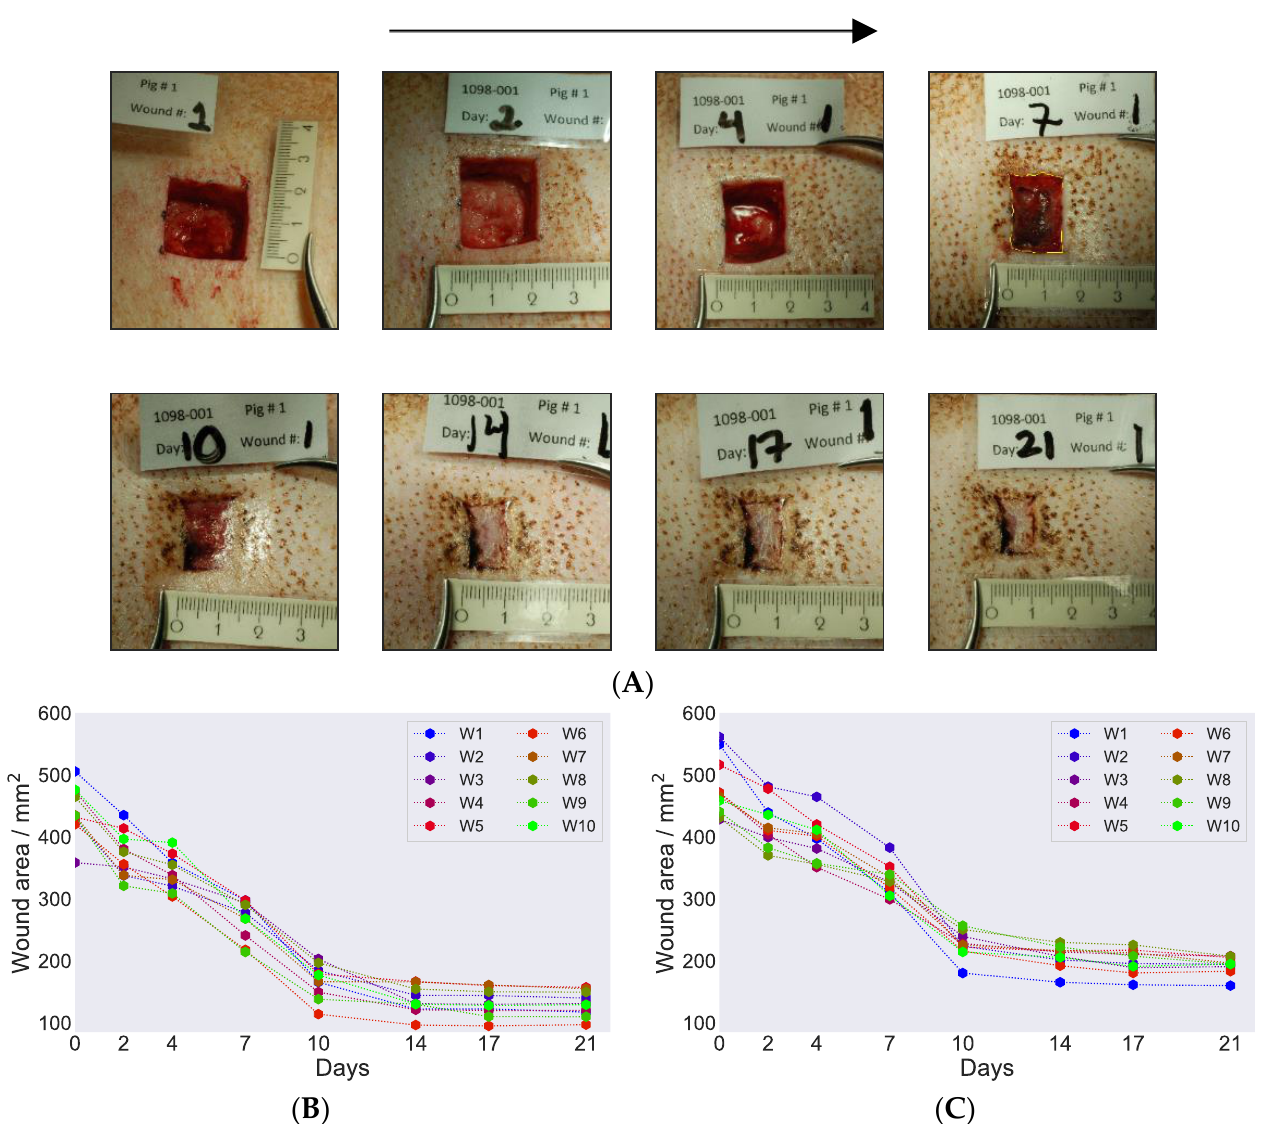
Figure 2. ( A ) Representative wound images on pig 1 at various time points during the healing progression cycle. The arrow on top of the figure indicates ascending date for healing cycle and the readers are encouraged to follow the images in the arrow direction. The images presented origin from position 1 and were captured on the days when the dressing was changed. The name plates on top of the images indicate the in vivo wound study number, pig number, study days when the wound dressing was changed, and the wound position number. The ruler on the bottom of the images was used as a guide to set the scale when calculating the wound marked area, e.g., see marking on day 7. Calculated wound area was presented as a function of days during the healing cycle for pig 1 ( B ) and pig 2 ( C ). The labelling W1, W2 and so on in the figure legends indicate the various wound positions on each pig.